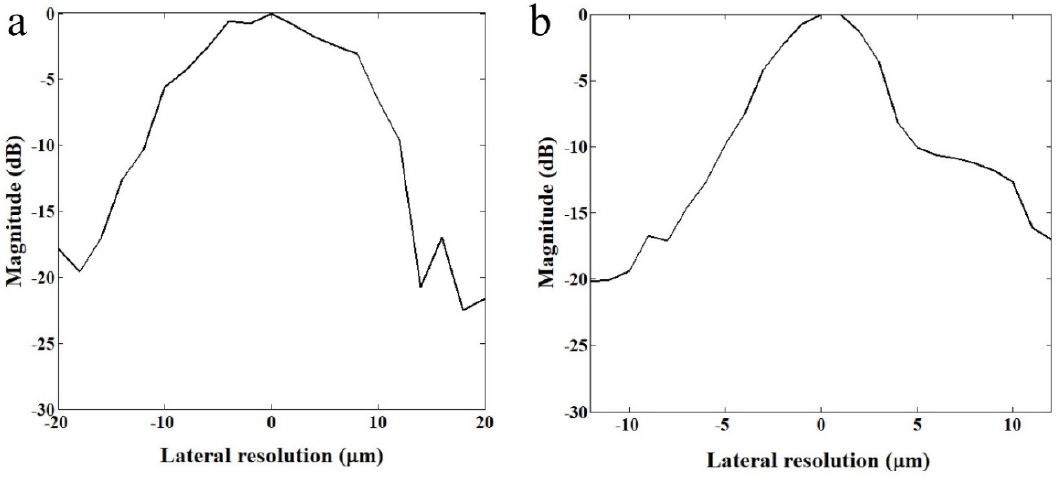
Figure 2. Relative magnitude distributions in lateral direction. ( a ) 110 MHz and ( b ) 410 MHz transducers.